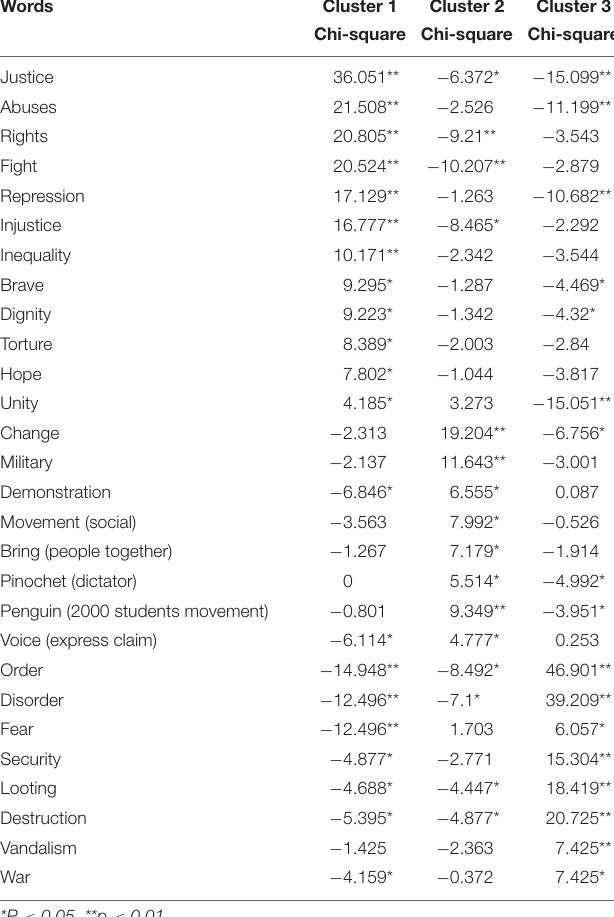
TABLE 5 | Words included in lexical classes.